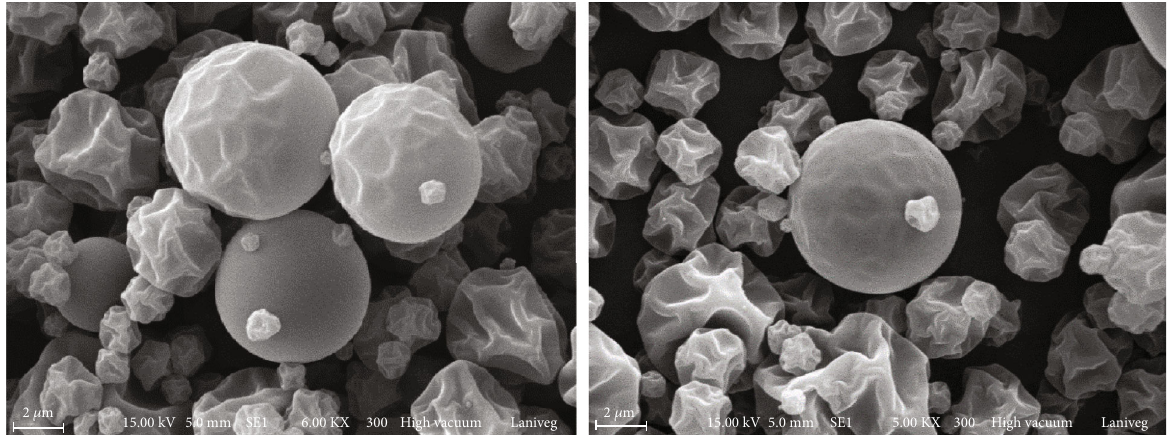
Figure 2: Micrographs of the microparticle structure of phenolic compounds of oregano (L ippia graveolens ) produced with maltodextrin 10 DE as wall material, using spray